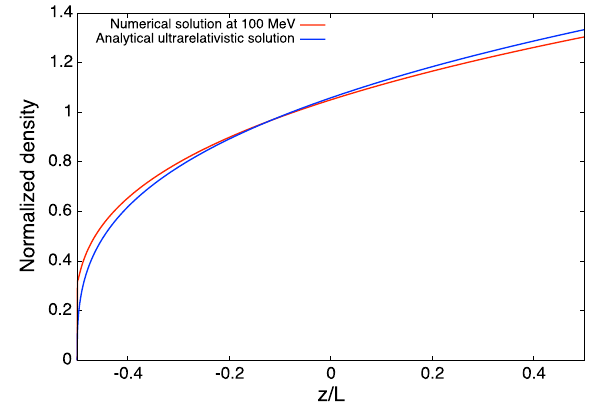
FIG. 2. (Red) Numerically computed solution of (25) for the longitudinal density. (Blue) Ultrarelativistic expression (15) for the longitudinal density. Here L is the total bunch length, and the vertical axis denotes the dimensionless quantity ð L=N Þ (cid:1)